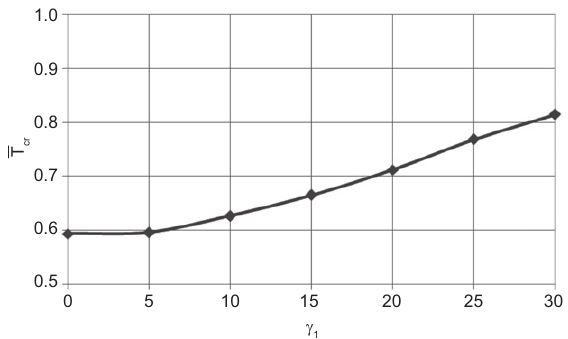
Figure 6 Effect of unsymmetric trapezoidal laminated plates on critical thermal buckling load.